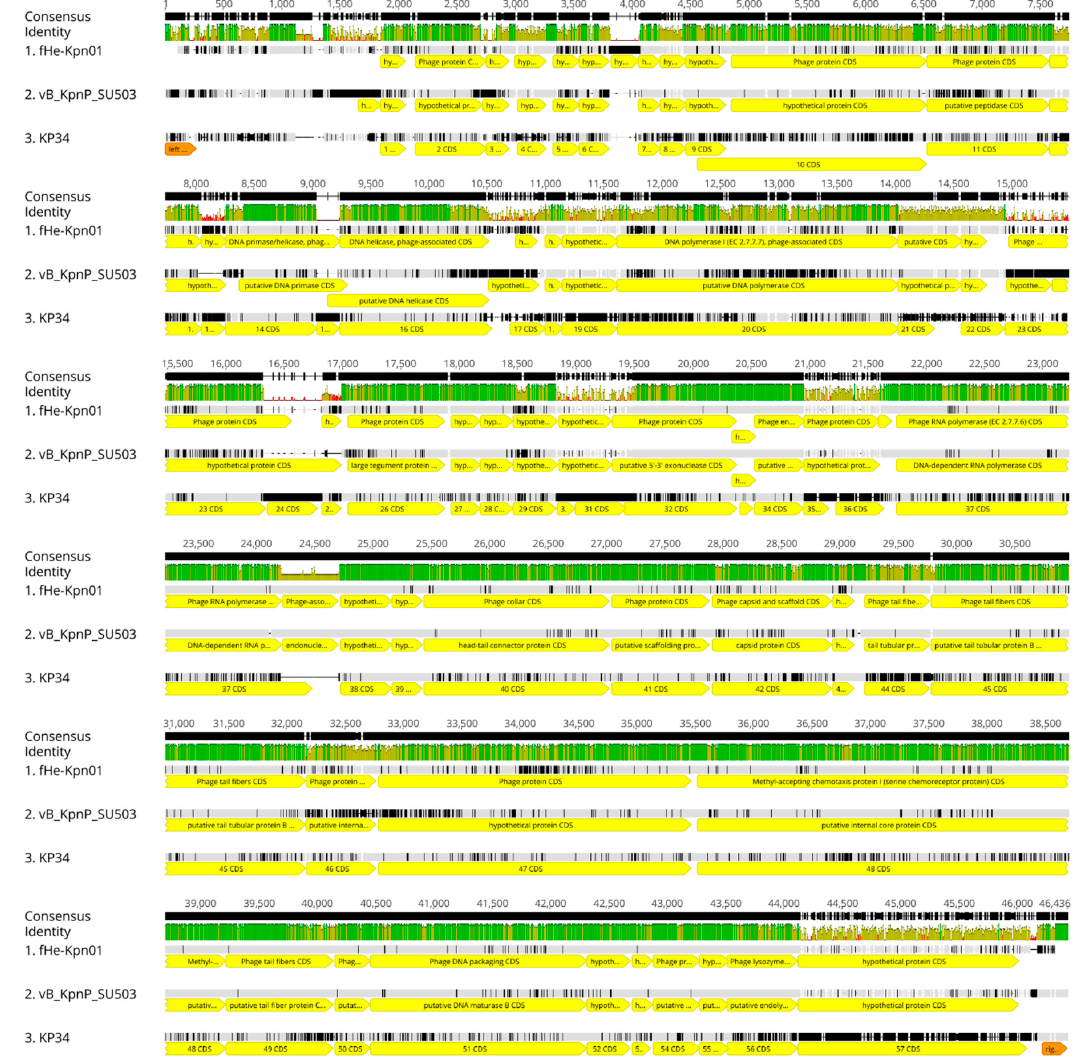
Figure 1. Alignment of the fHe-Kpn01 genome with the closest related phage vB_KpnP_SU503 (NC_028816; 43,809 bp) and KP34 (NC_013649: 43,809 bp), the type phage of the drulisviruses. The genes are represented by yellow arrows. A green area in the consensus identity indicates high similarity and a red area indicates low similarity between the three phages. Generated with Geneious v11.1.5 [50] .